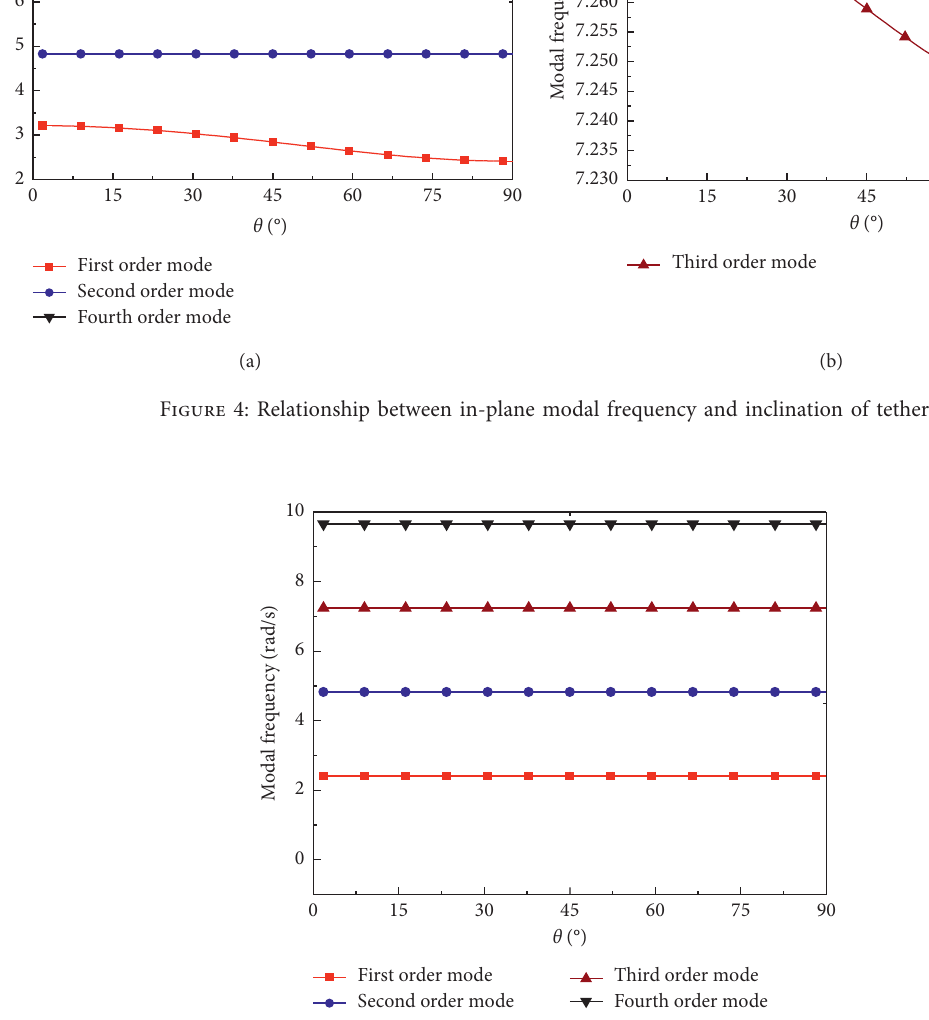
Figure 5: Relationship between out-of-plane modal frequency and inclination of